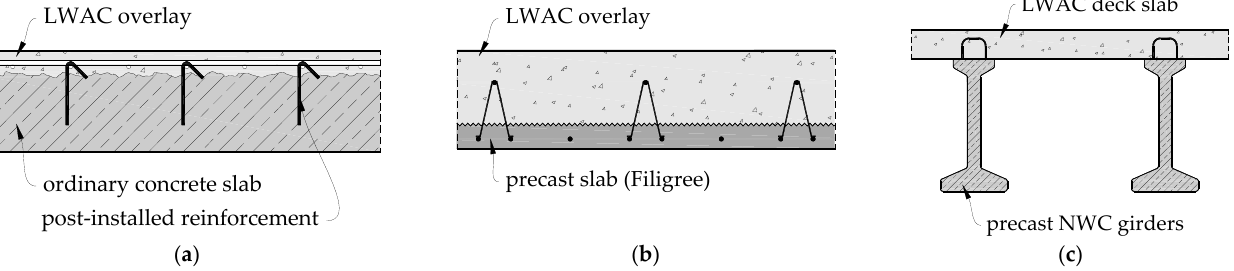
Figure 1. Examples of the use of lightweight aggregate concrete as structural overlay: ( a ) flat slab strengthened with concrete overlay; ( b ) composite slab with Filigree precast elements; ( c ) bridge decks.